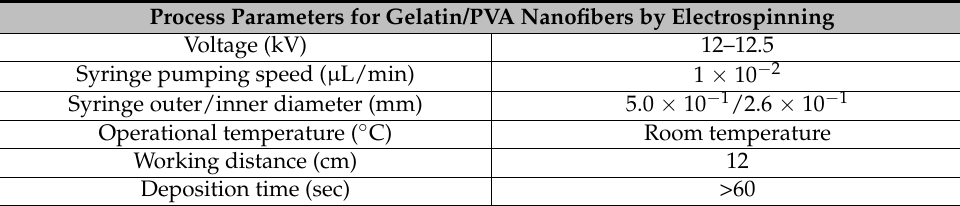
Table 2. Parameters for electrospinning gelatin/PVA mixed